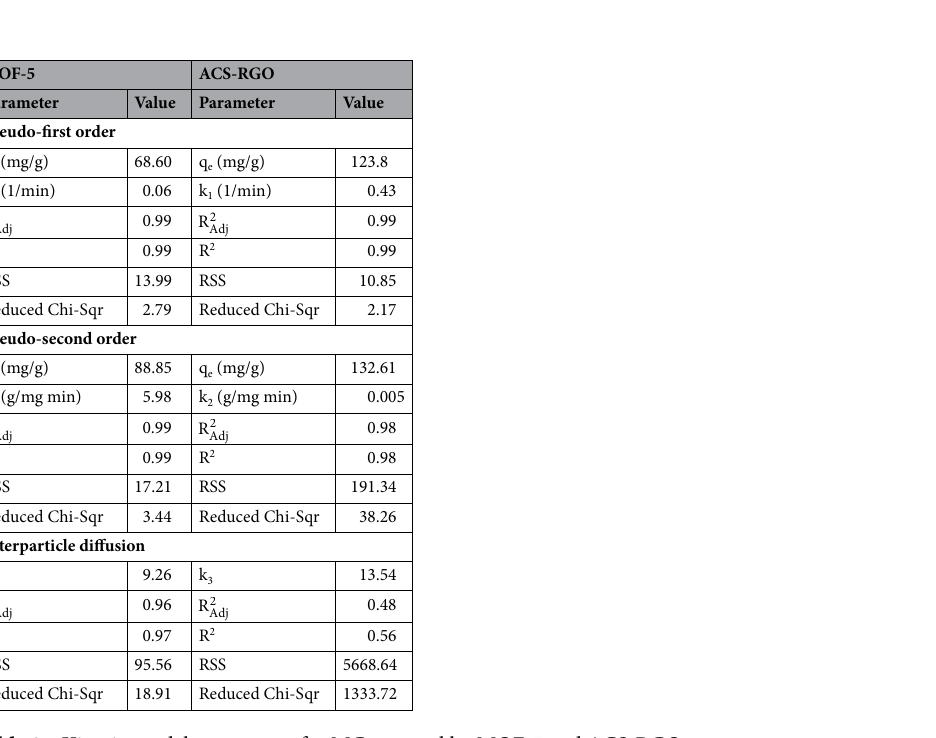
Table 2. Kinetic model parameters for MG removal by MOF-5 and